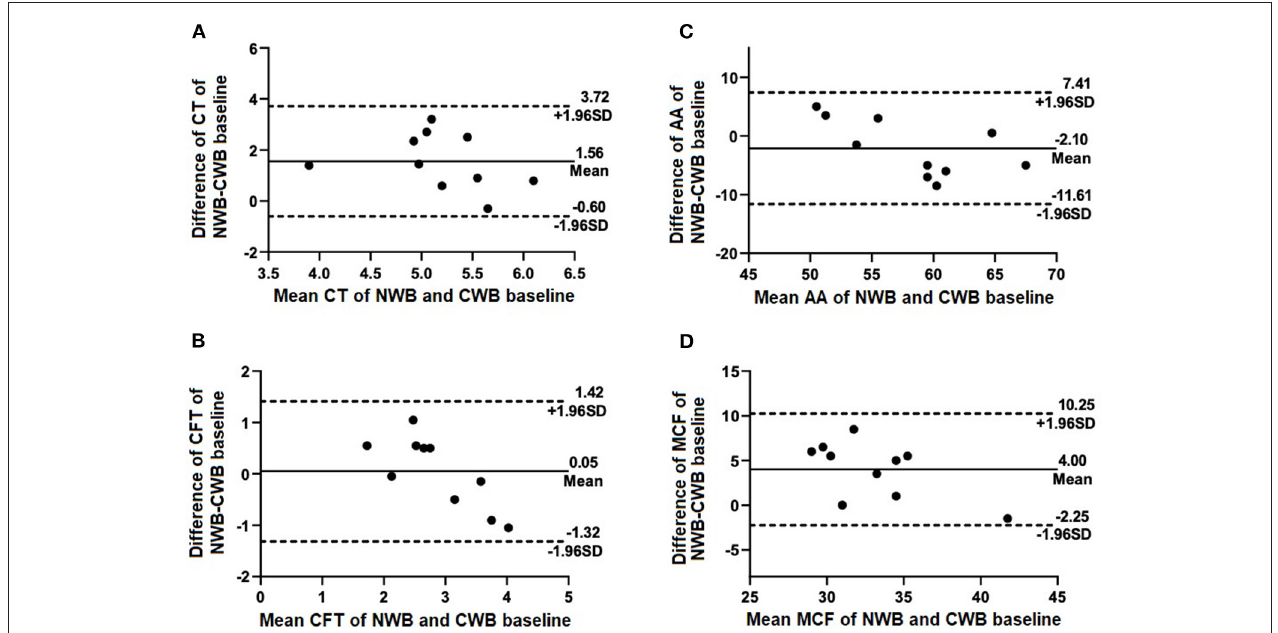
FIGURE 1 | Selected Bland-Altman plots indicating biases of measured parameters of NWB (control) compared with CWB baseline. Mean difference (bias) is indicated by solid lines with dashed lines indicating 95% agreement interval of + / − standard deviations. Parameters included are (A) CT, (B) CFT, (C) AA, and (D) MCF.